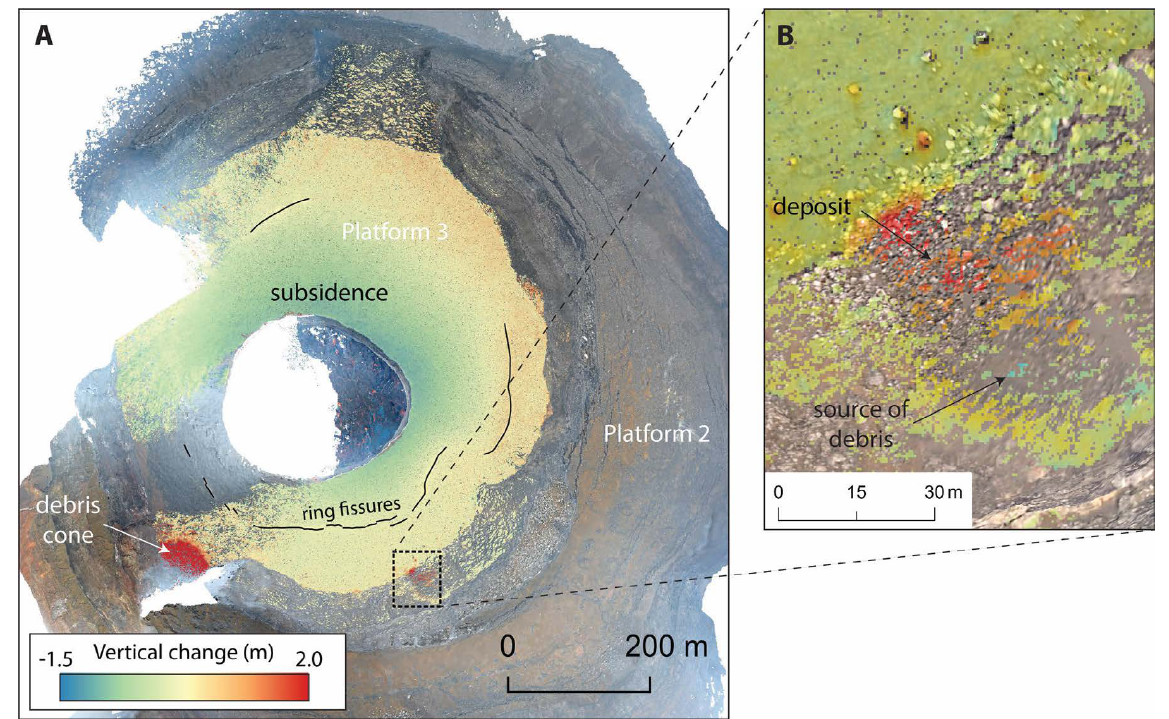
Figure 11: Topographic evolution of the Nyiragongo main crater, D. R. Congo, between March 2013 and July 2014, based on images collected with Nikon D3 and Nikon D7000 cameras, during helicopter and UAS flights. The ground sampling distance is ~30 cm. [A] Point cloud di ff erence superimposed on the July 2014 crater orthophoto. Topographic changes include a ground subsidence associated with a long-term lava lake level drop during that period and cones of debris located at the foot of gullies and cli ff s. [B] Enlargement of a cli ff region between Platform 2 and 3 in the crater, with evidence of the fallen debris deposit and its source area. Reproduced from Smets